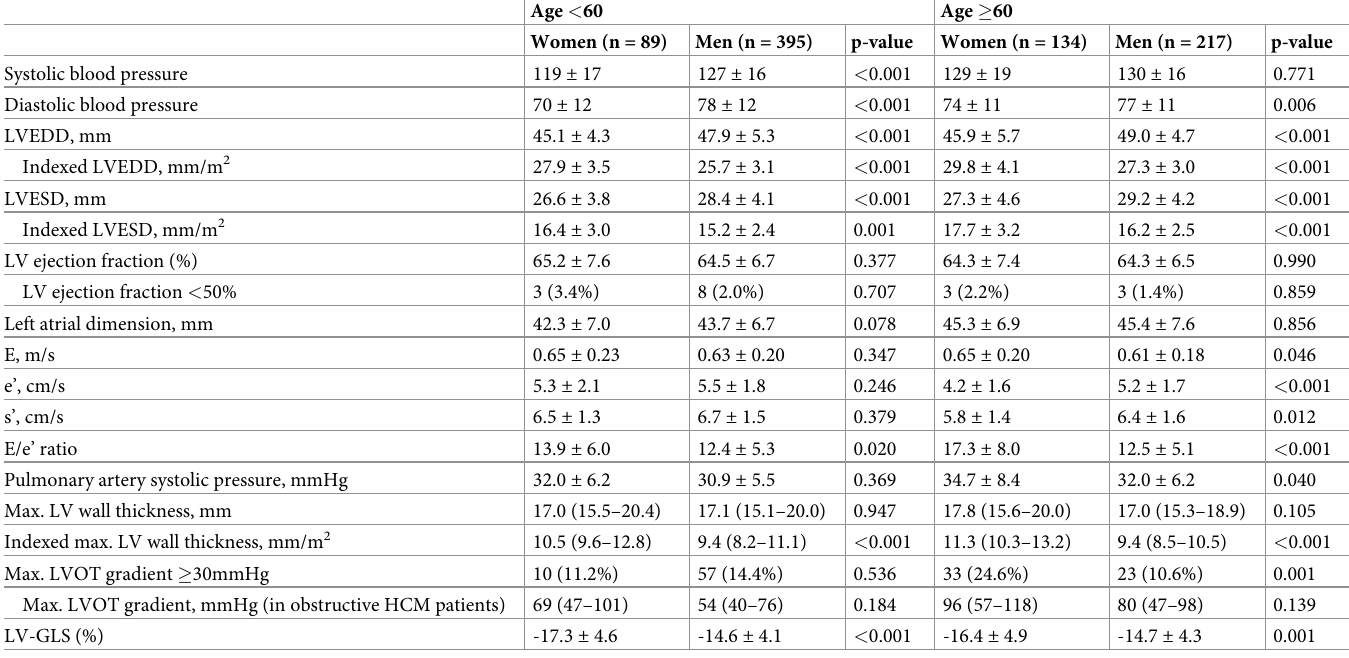
Table 2. Comparison of echocardiographic characteristics between the sexes at age under and over